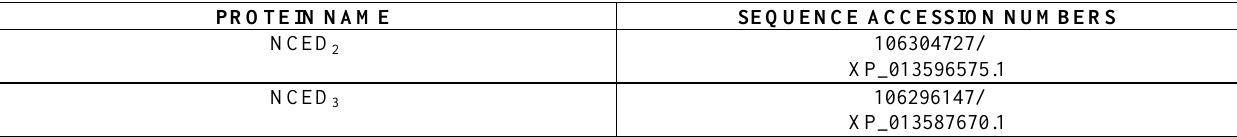
Table 1. Accession numbers of Brassica oleracea NCED